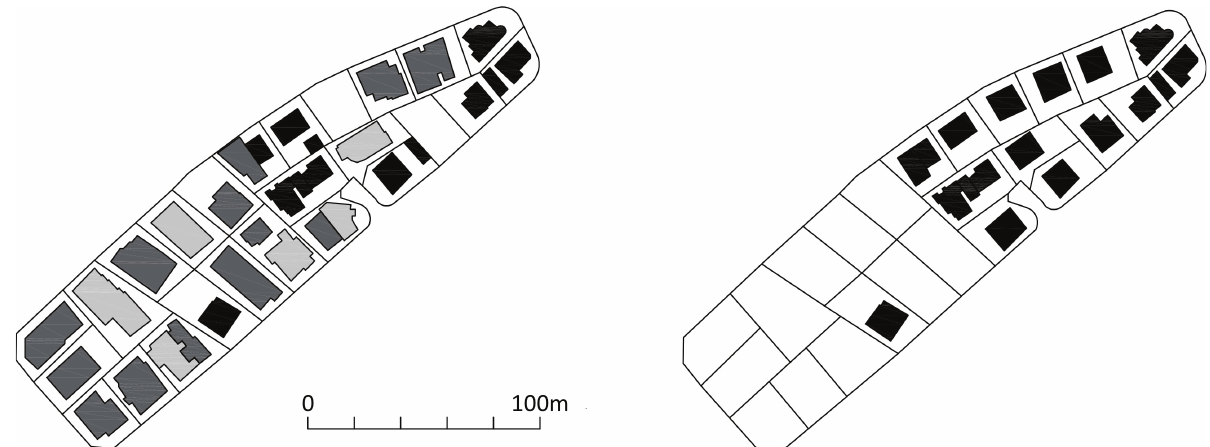
Figure 3. Left—Suburban block construction phases today: prior to 1963 (black), 1970s to early 1990s (grey), less than 20 years old (light grey). Right—Suburban block in